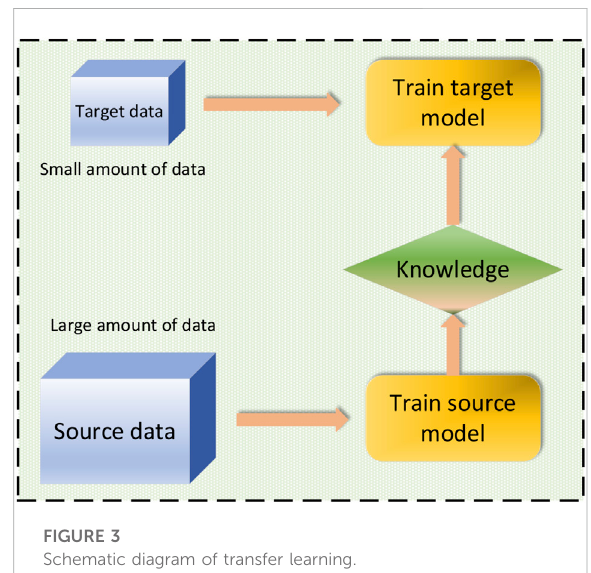
FIGURE 3 Schematic diagram of transfer